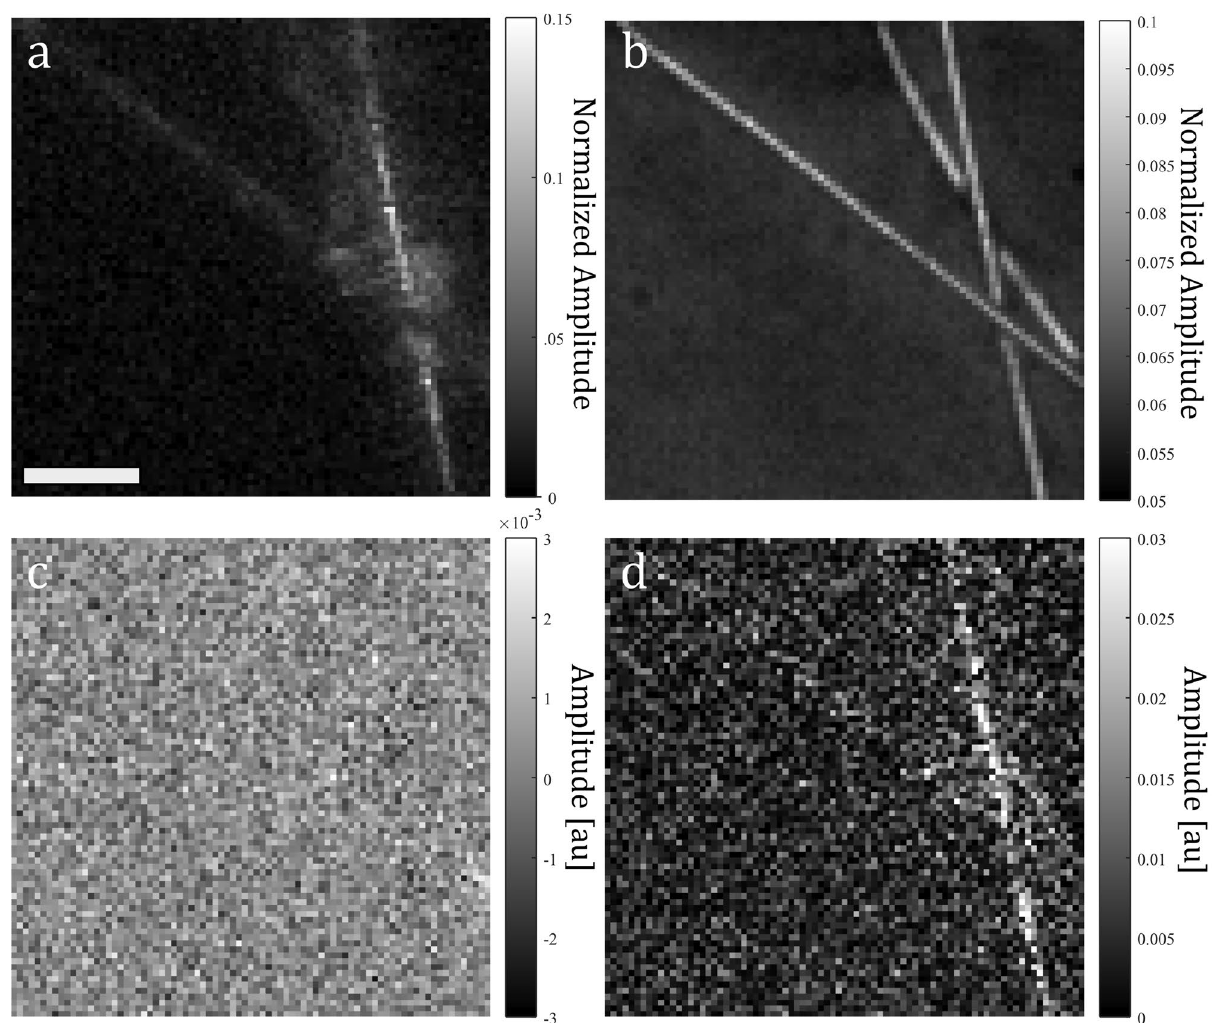
Figure 2. Results from three sequential acquisitions imaging 25 µ m diameter gold wires covered with a layer of water and coverslip: ( a ) excitation frame from acquisition A; ( b ) mean of the pre-excitation frames from acquisition B; ( c ) difference between the mean of the pre-excitation frames in acquisition B and mean of frames in acquisition C; ( d ) difference between the excitation frame in acquisition B and the output in ( b ) followed by a difference between this result and the output in ( a ). Scale bar: 100 µ